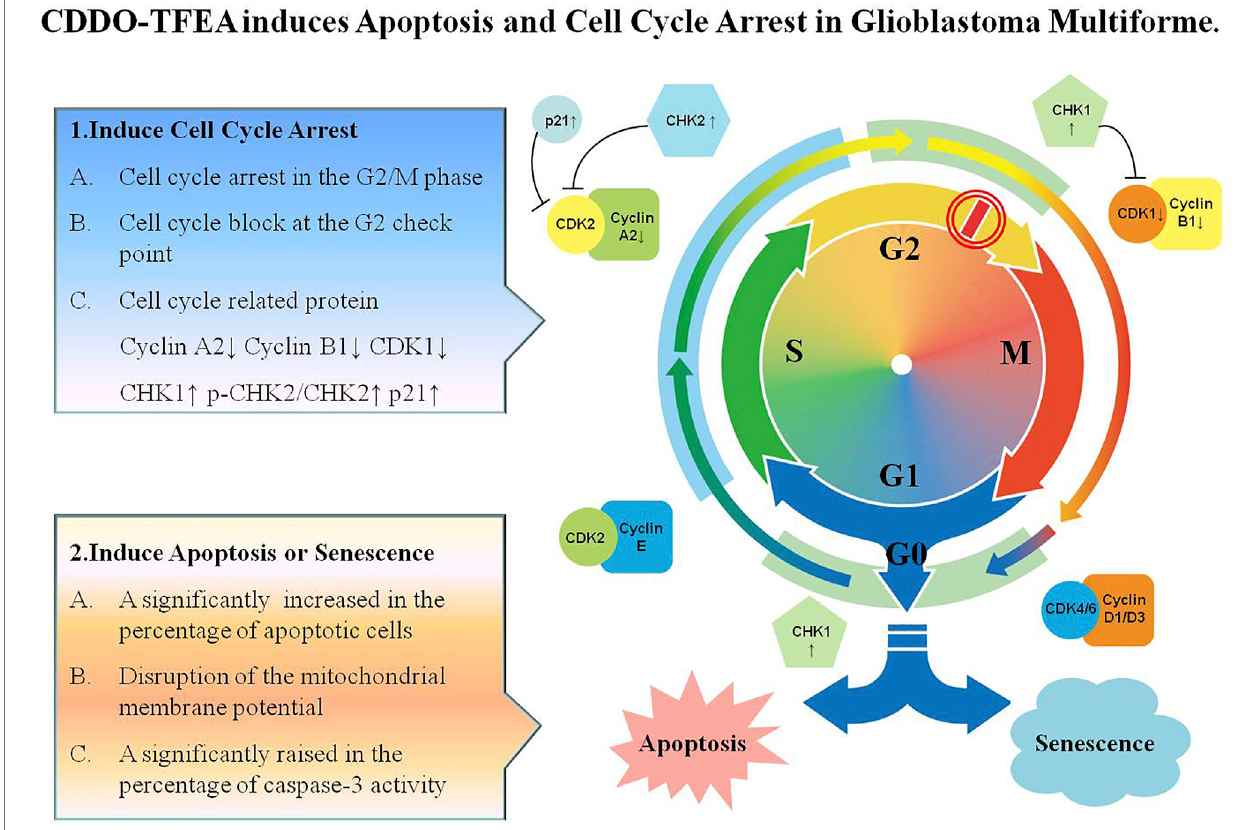
FIGURE 9 | CDDO-TFEA induces apoptosis and cell cycle arrest in Glioblastoma Multiforme. CDDO-TFEA may not only induce cell cycle arrest but also induce apoptosis in established GBM cells. G1 phase: Growth 1 phase. S phase: Synthesis phase. G2 phase: Growth 2 phase. M phase: mitosis. CDK1: Cyclin Depandant Kinase 1. CDK2: Cyclin Depandant Kinase 2. CHK1: Checkpoint Kinase 1. CHK2: Checkpoint Kinase